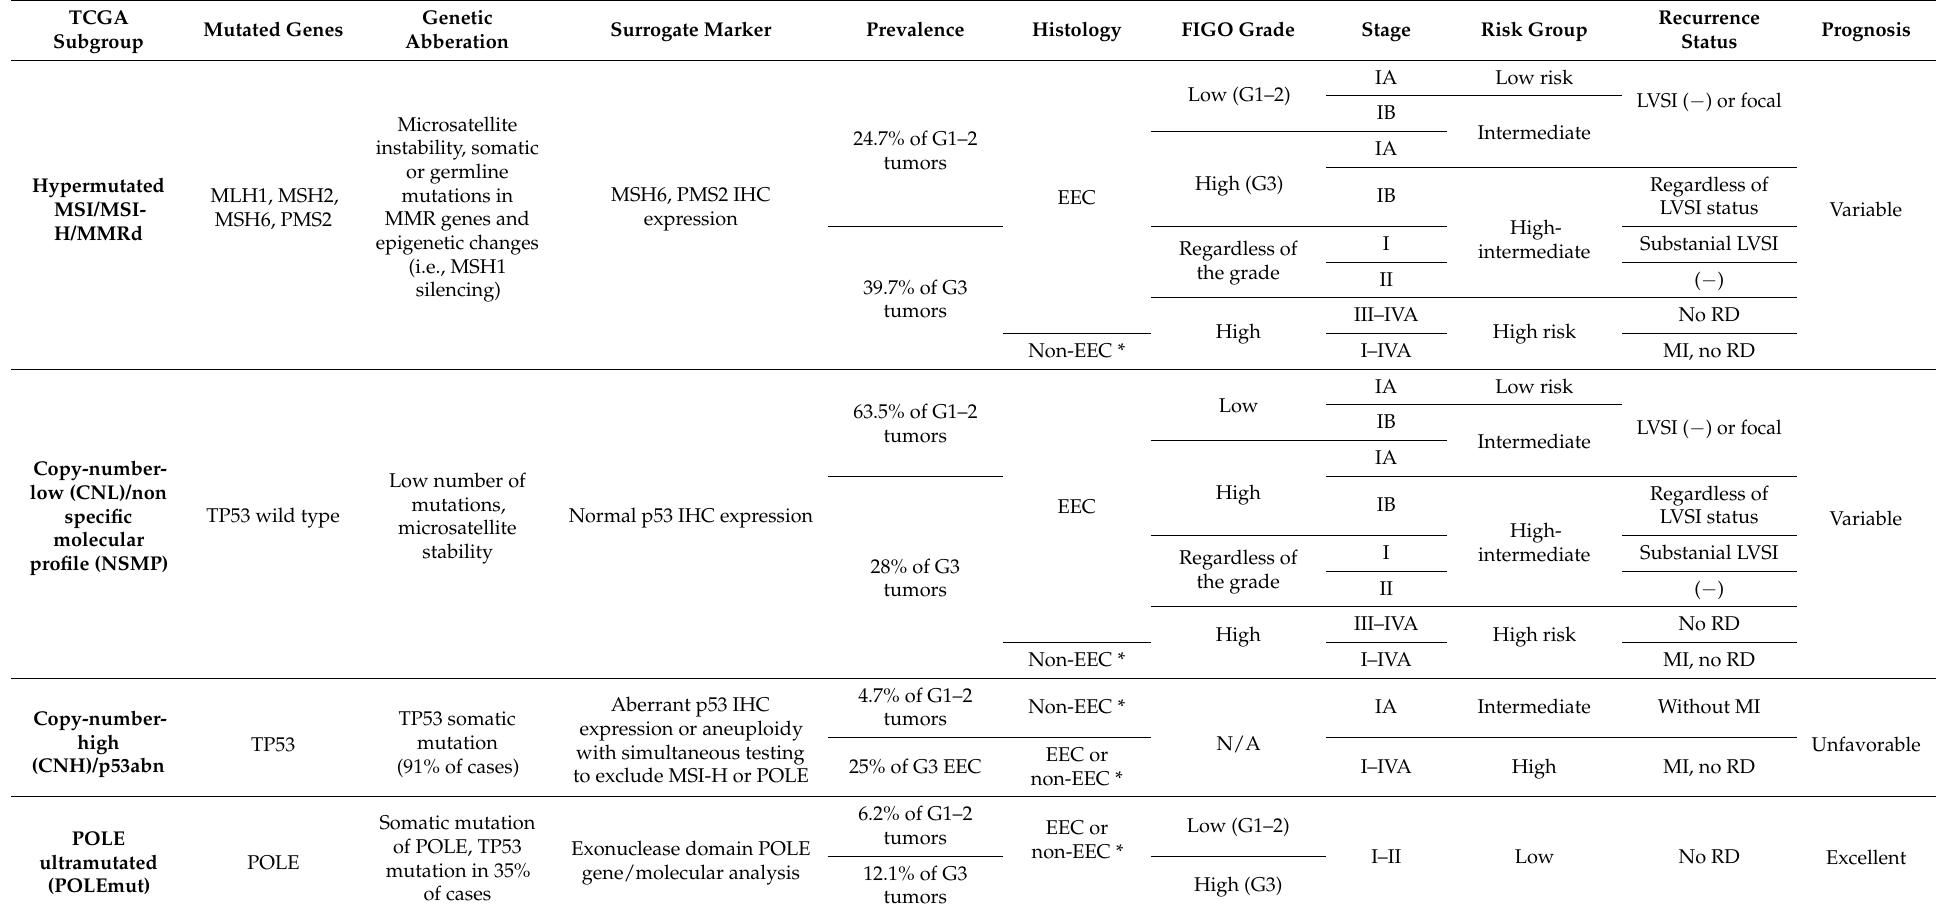
Table 1. Molecular classification of Endometrial Cancer and correlation with previous classification